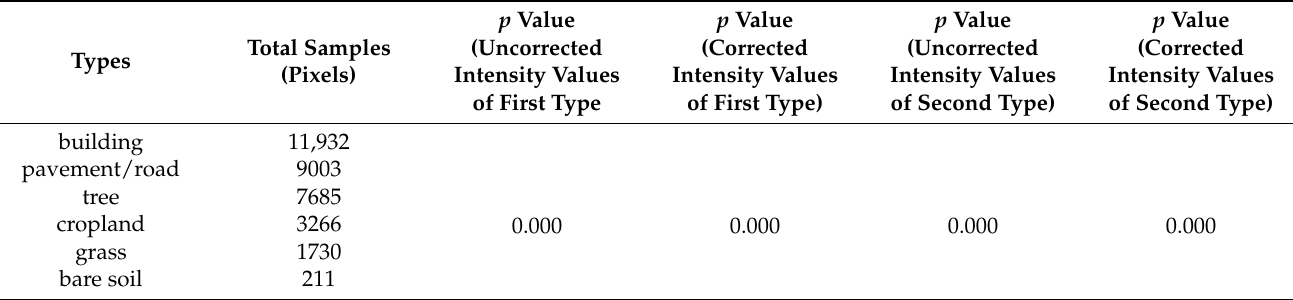
Table 1. The total number of training and verification samples for six land cover types and independent-sample test for difference.